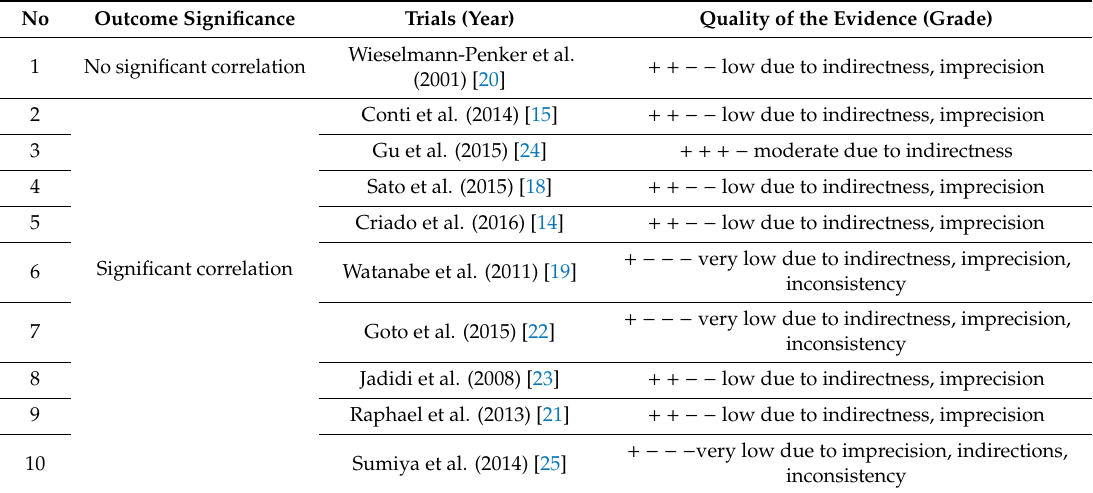
Table 3. Summary findings for the primary